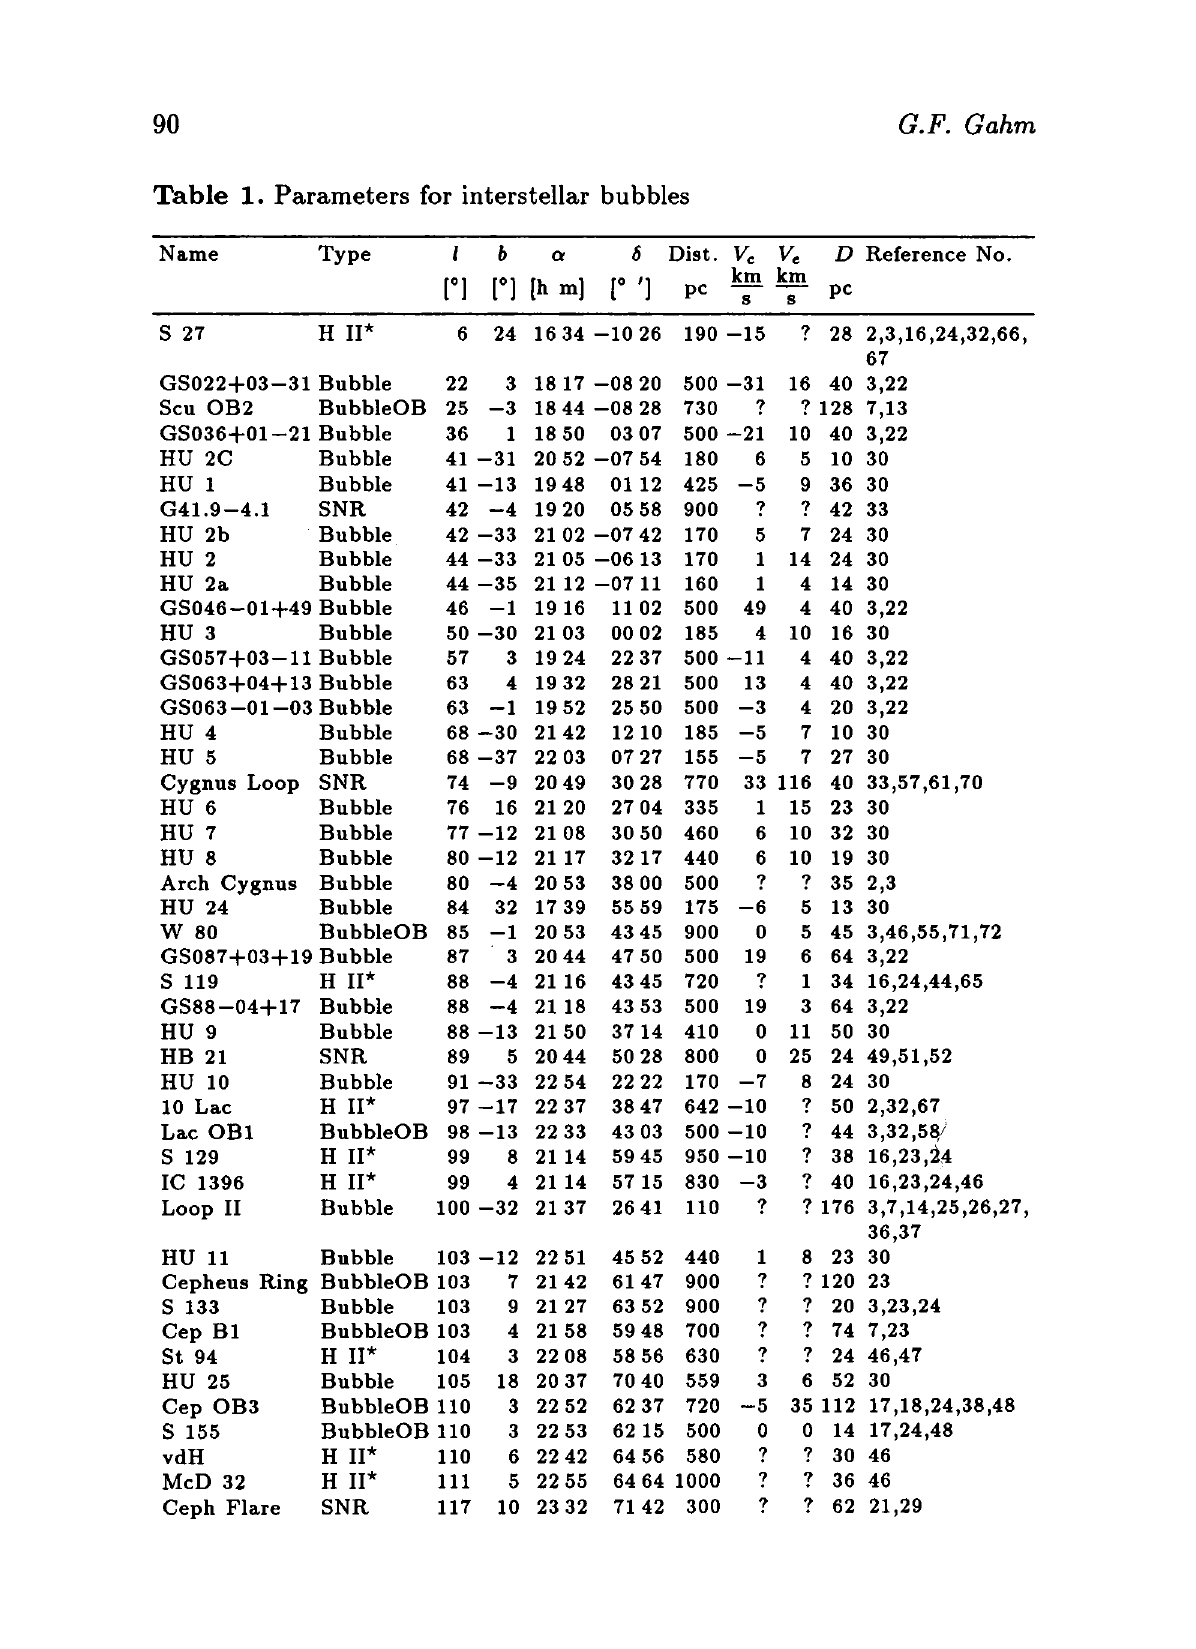
Table 1. Parameters for interstellar